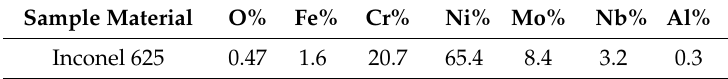
Table 7. Chemical composition at Inconel 625 surface after machining and EB welding, untested.